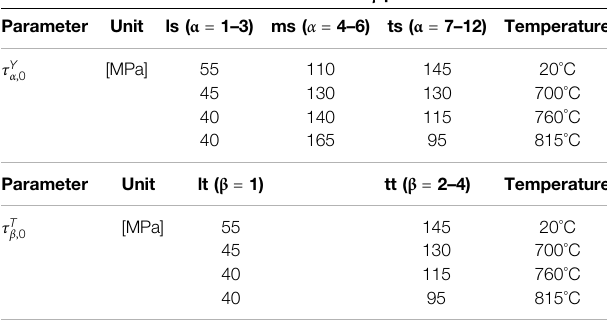
TABLE 6 | Identi fi ed initial critical resolved shear stresses in the γ phase as a function of temperature for the PST crystals tested in Parthasarathy et al.